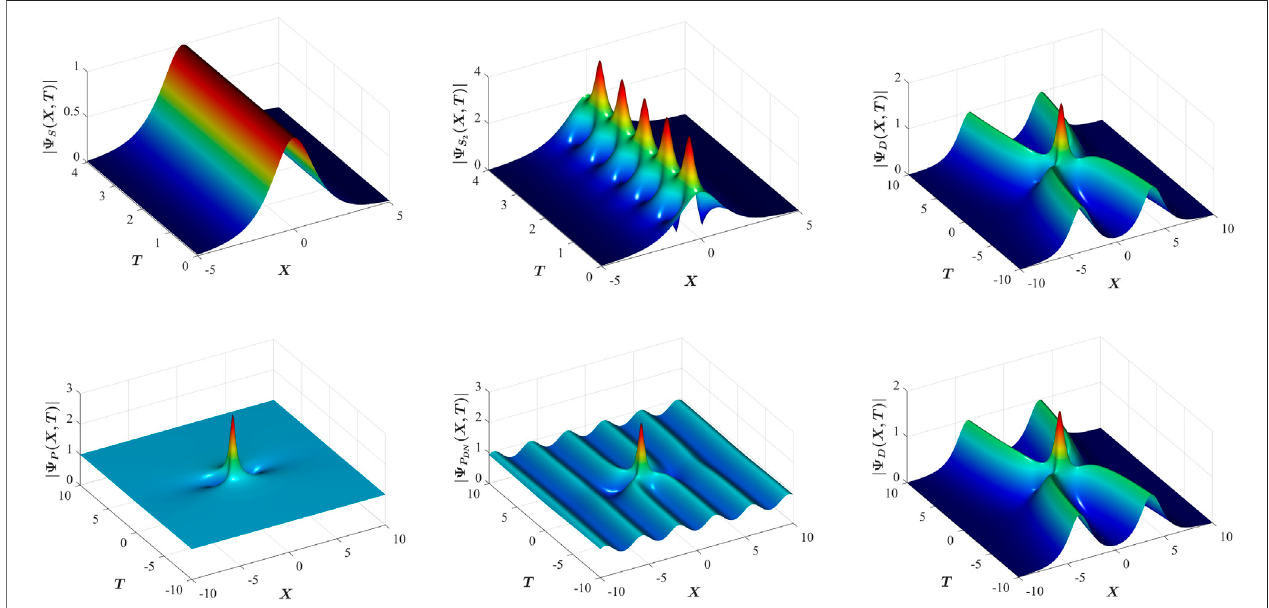
FIGURE 1 | Spatio-temporal evolution of solitons on fi nite and zero-background. Top left : single envelope soliton. Top middle : Higher-order soliton of order 2. Top right : Degenerate two-solution solution. Bottom left : Peregrine breather. Bottom middle : Peregrine breather on a dnoidal background. Bottom right : Degenerate two-soliton